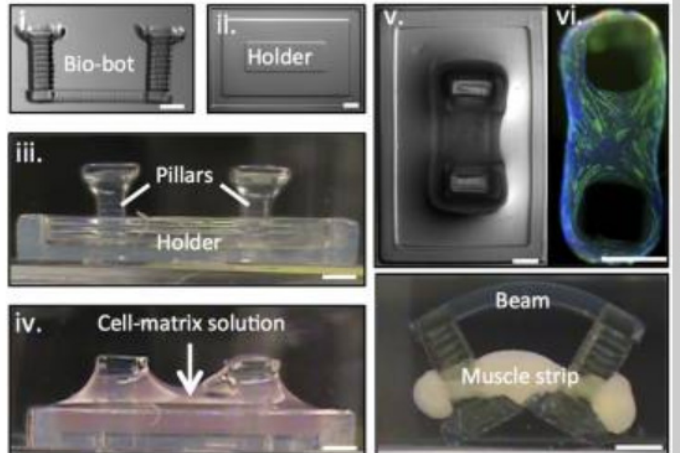
Figure 15 . Assembly process of a hydrogel micro-SLA-printed bio-bot, actuated with skeletal muscle. The biobot ( i ) is placed within the holder ( ii ), and the assembly ( iii ) is filled with the cell-matrix solution. This material is compacted around the biobot pillars to form a solid muscle strip ( v ) and with immunostaining ( vi ). The final device is shown in the bottom-right. All scale bars here are 1 mm [104].